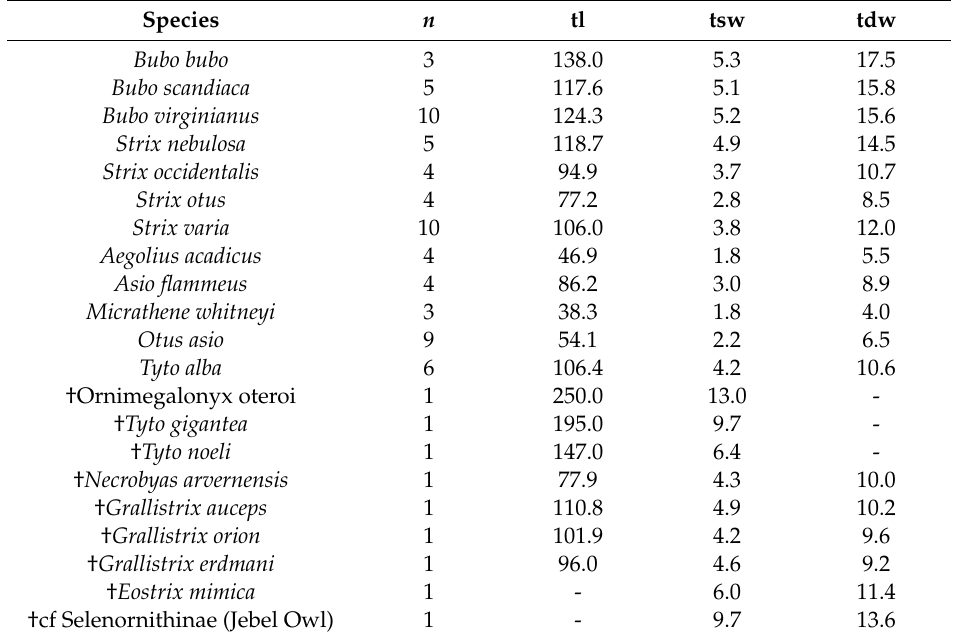
Table 1. Tibiotarsal measurements of selected extant and large extinct species of owls